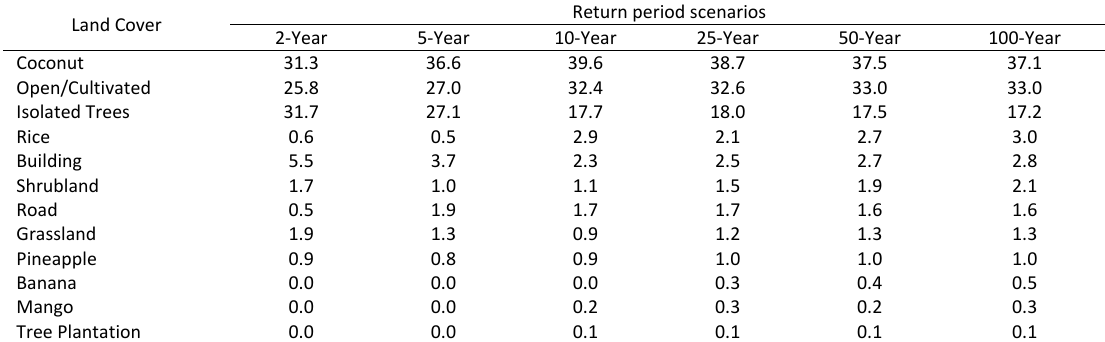
Return period scenarios